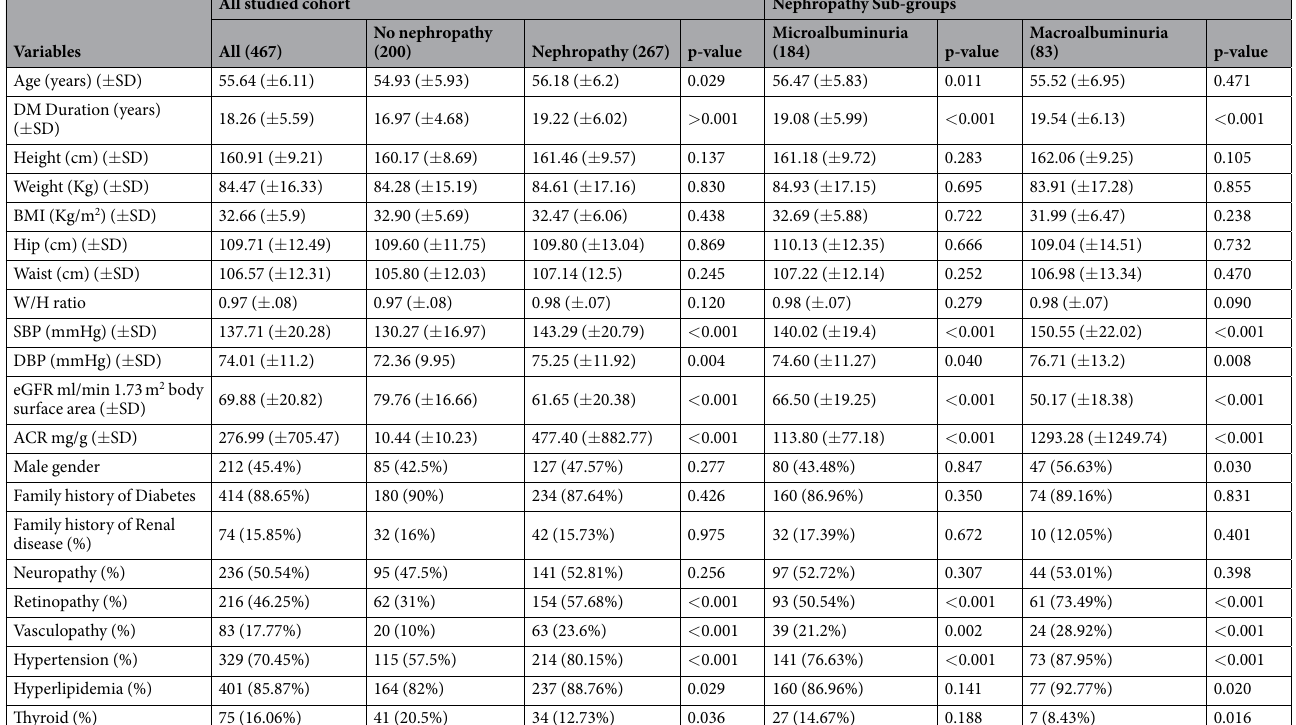
Table 1. Baseline characteristics of the studied subjects according to their diabetic nephropathy stages. ACR: Albumin creatinine ratio; BMI: body mass index; DM: diabetes mellitus; DBP: diastolic blood pressure; eGFR: estimated glumerular filtration rate; SBP: systolic blood pressure; W/H ratio: waist to hip ratio. P value was calculated in reference to the patients without diabetic